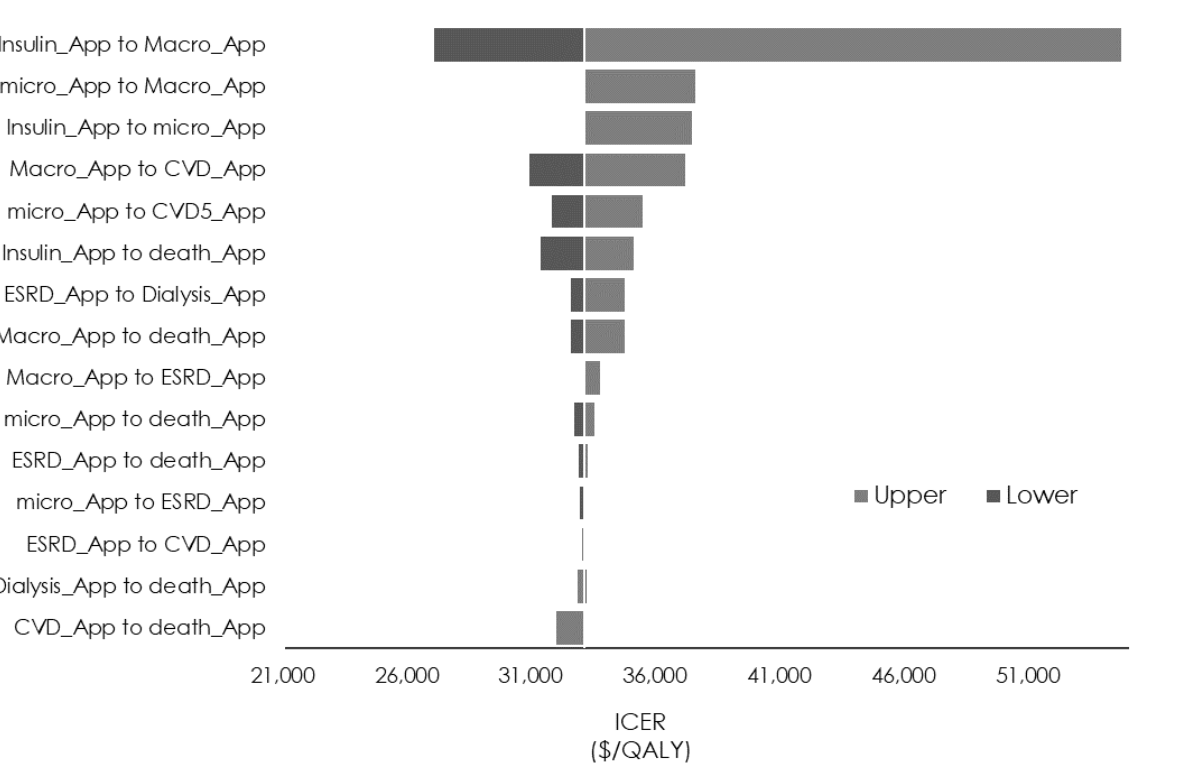
Figure 2. Sensitivity analysis of the incremental cost-effectiveness ratio (ICER) using transition probabilities. CVD: cardiovascular disease; ESRD: end-stage renal disease; QALY: quality-adjusted life